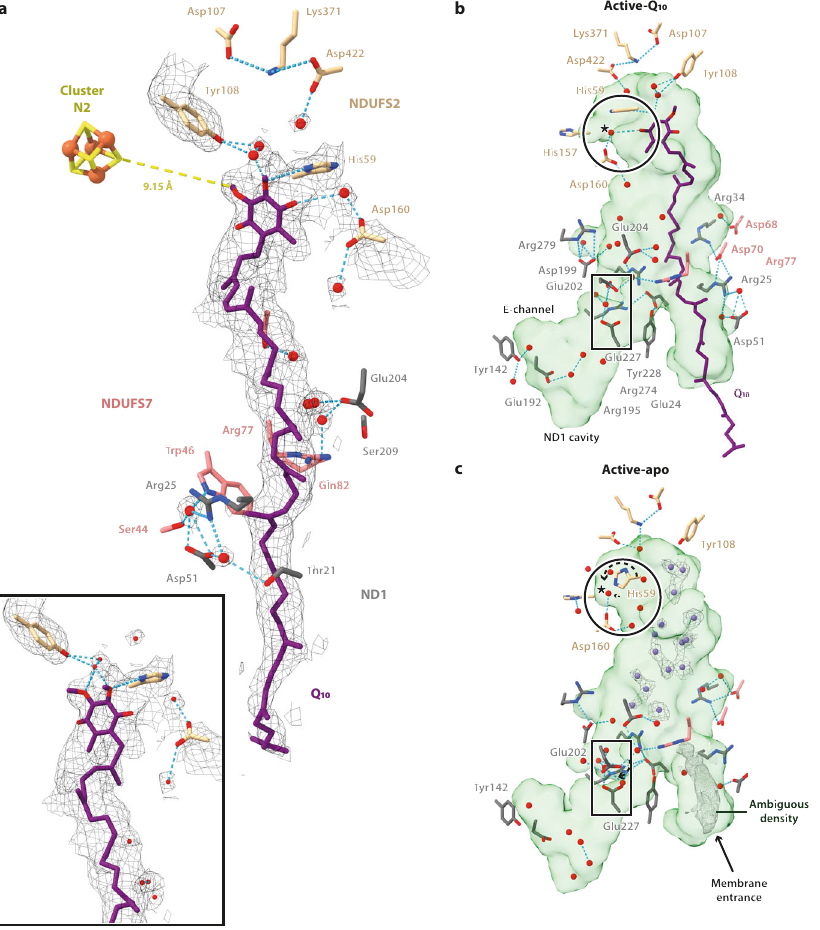
Fig. 2 Active states of complex I with and without bound Q 10 . a Cryo-EM densities of Q 10 and neighbouring water molecules in the active-Q 10 map at a map threshold of 4.4 are shown together with the polar residues that make H-bonding interactions, as identi fi ed using the hbonds command in UCSF ChimeraX 51 . The inset shows an alternate conformation of Q 10 that can be modelled into the density. The independent model-map CC mask values for the primary and secondary Q 10 poses are 0.72 and 0.70, respectively. Protonatable residues, water molecules (red spheres) and ligands in close proximity to the Q-binding channel and ND1 cavity (the green surfaces identi fi ed by CASTp 45 ) are shown and labelled in the ( b ) active-Q 10 and ( c ) active-apo states. Star (*) indicates a water molecule that moves as a result of the rotation of His59 NDUFS2 (dotted arrow; circled). The unidenti fi ed density and densities for the dynamic water molecules (violet spheres) in the active-apo map are shown at a map threshold of 4.0 in UCSF ChimeraX 51